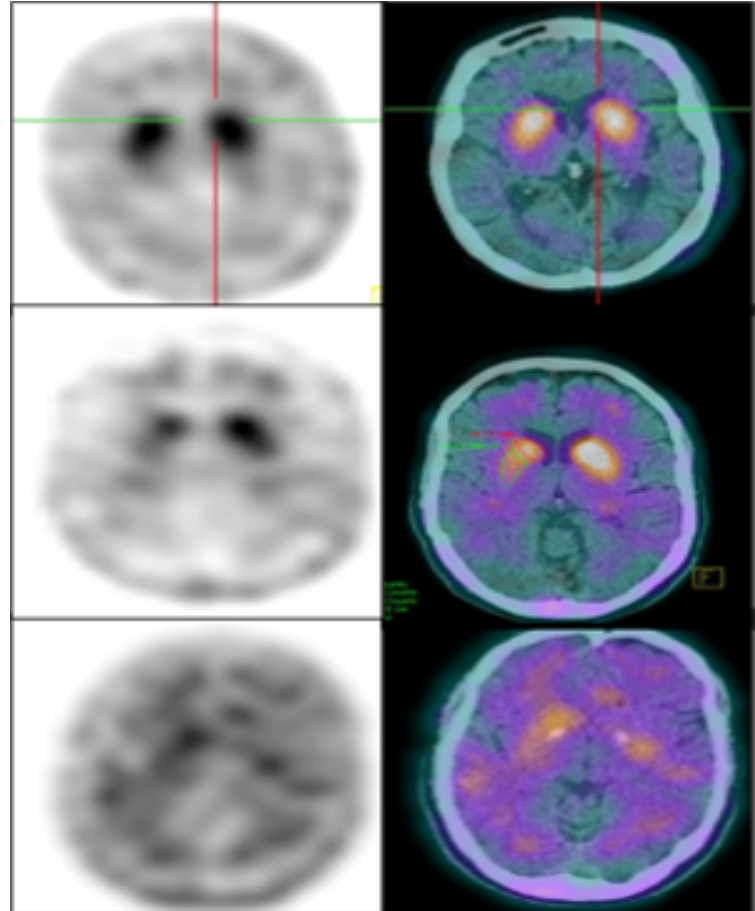
Figure 2. Dopamine transporter uptake in basal ganglia shown by SPECT or